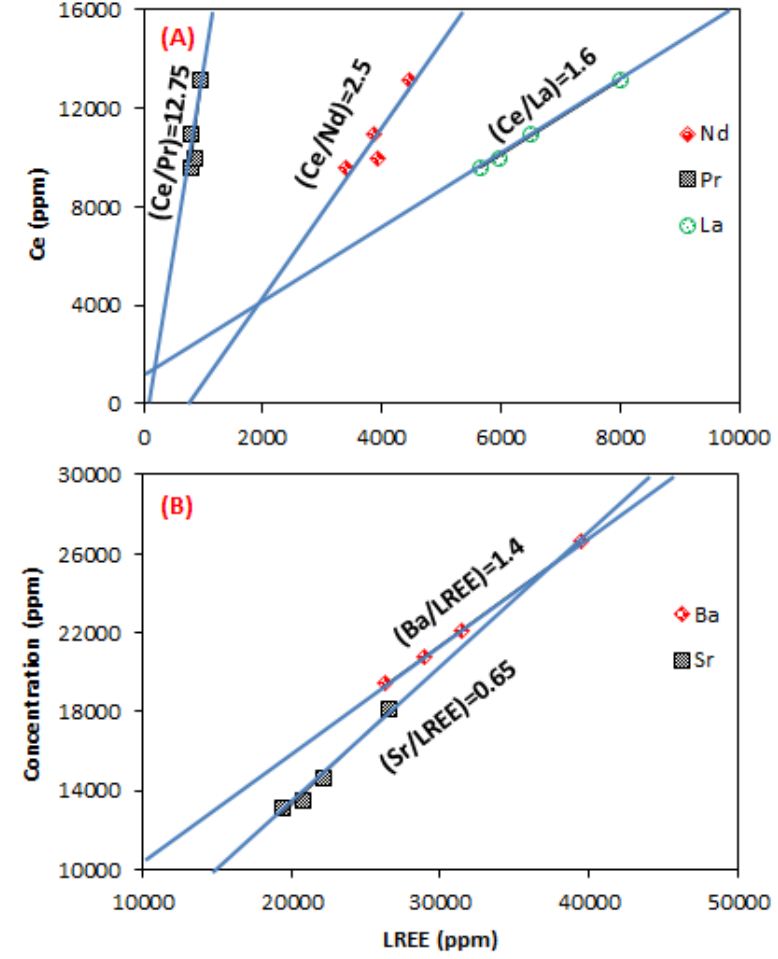
Figure 3. Correlation between LREE (Ce vs. La, R 2 = 0.99; Ce vs. Nd, R 2 = 0.93; Ce vs. Pr, R 2 = 0.91) ( A ), LREE vs. Ba (R 2 = 0.99) and LREE vs. Sr (R 2 = 0.98) ( B ).